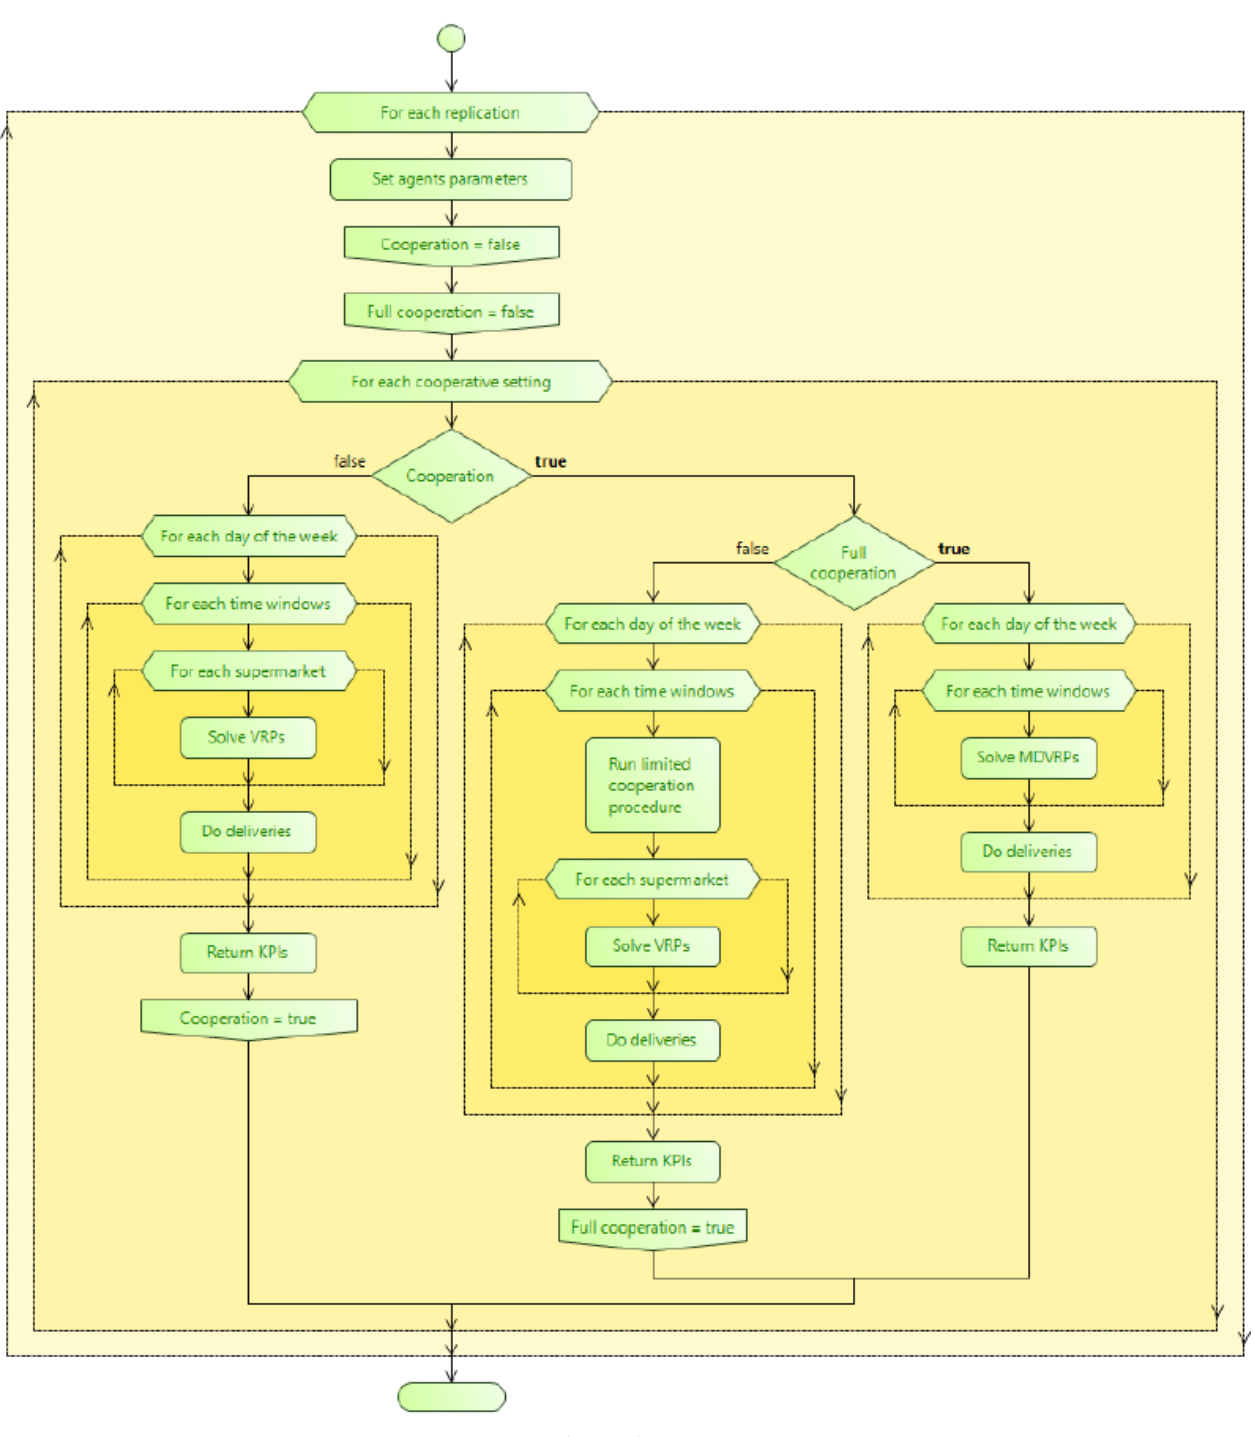
Figure 8. Simulation dynamics